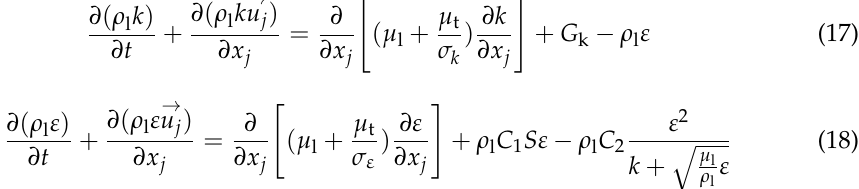
Table 1. Detailed parameters used in simulations.